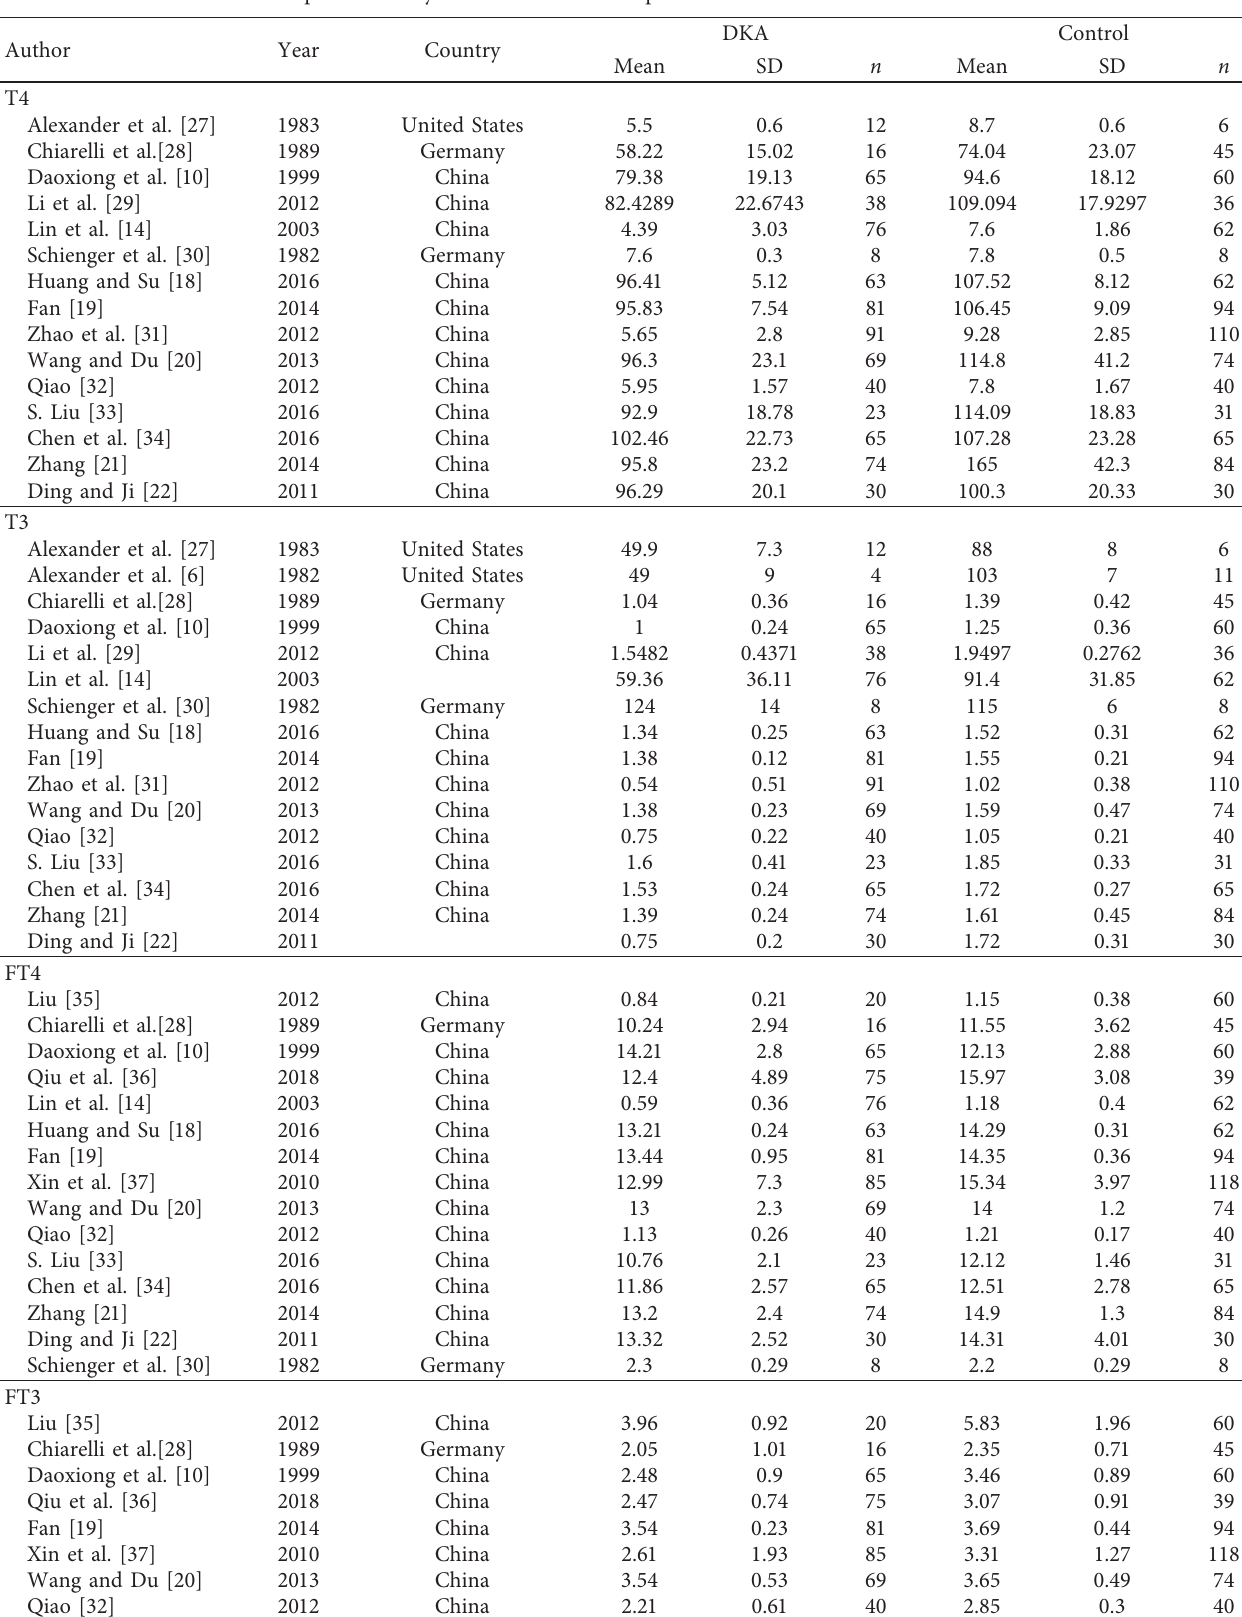
Table 3: Comparison of thyroid function between patients with diabetes with and without